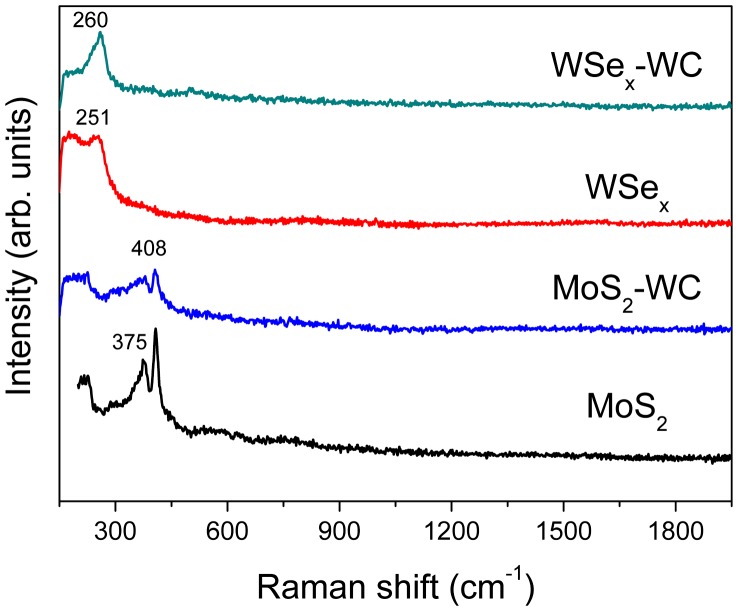
Raman spectra of the MoS2 and WSe2-based coatings.